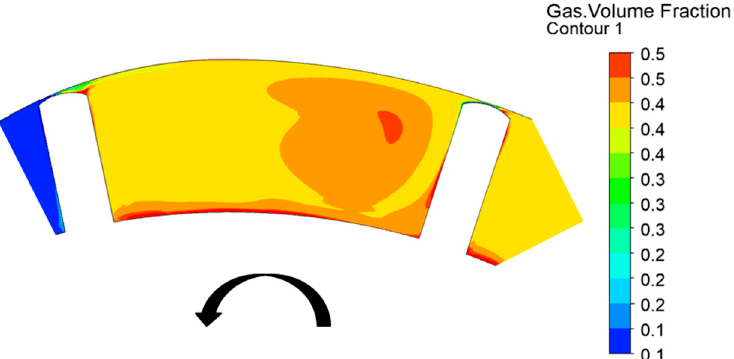
Figure 30. Free air gas volume fraction distribution for a single displacement chamber at 5 bars, 2000 rpm and an IGVF of 40%.